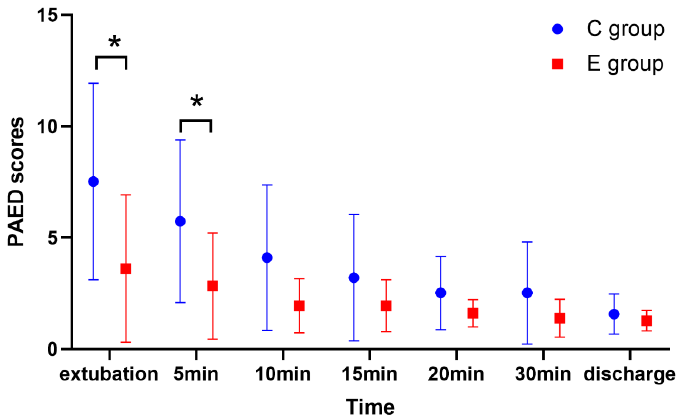
Figure 4. PAED scores at different time points. PAED, Pediatric Anesthesia Emergence Delirium; * p < 0.05.